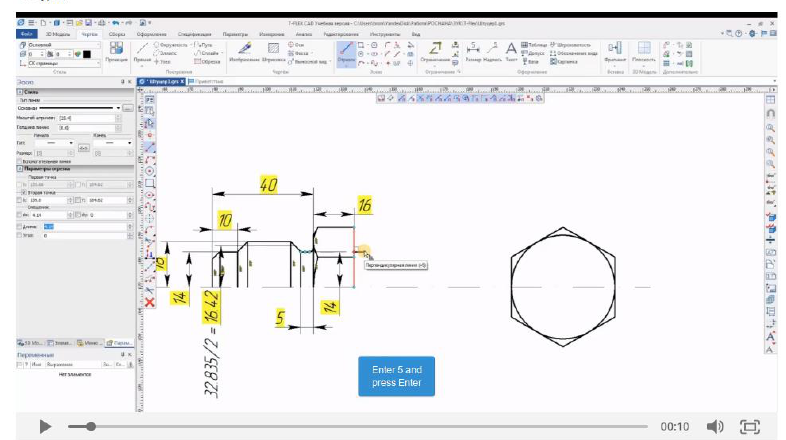
Fig. 8. Hints in the video sequence (blue rectangle).